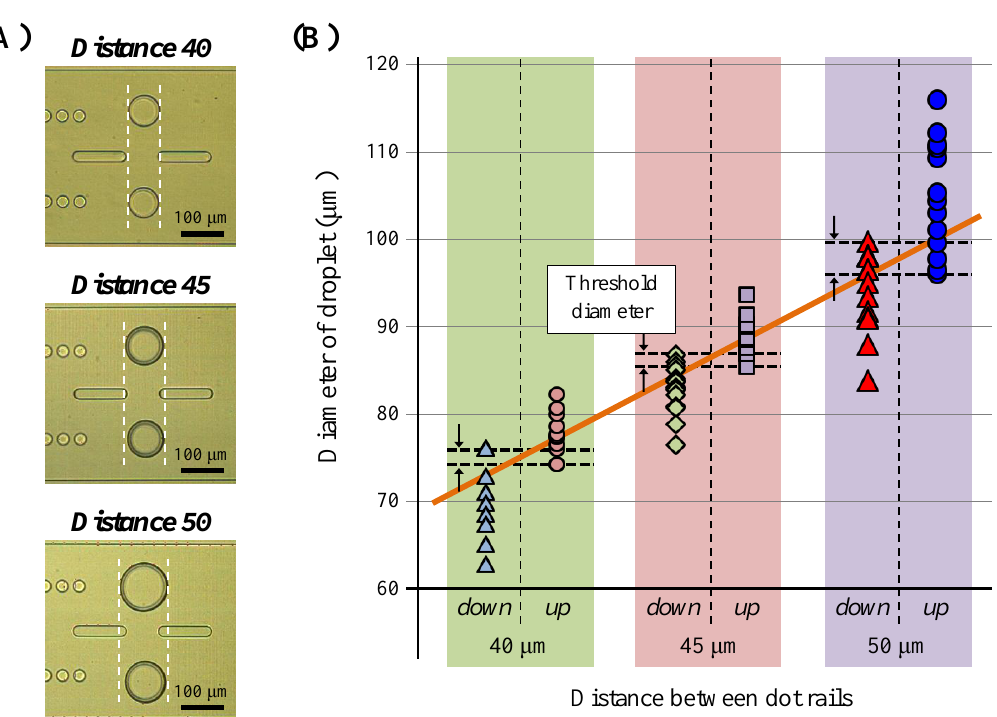
Figure 6. Sorting the results of water droplets using different rail distances. ( A ) Captured images of droplets sorted into different rails by size (images of droplets were treated to evaluate them in the same position). ( B ) Droplet volumes sorted by different rails in each rail type and the threshold diameter of droplet